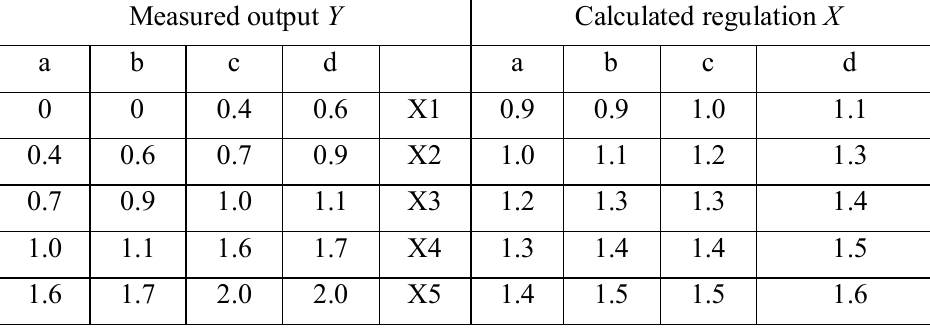
Table 3 - Definition of fuzzy sets and regulation rules